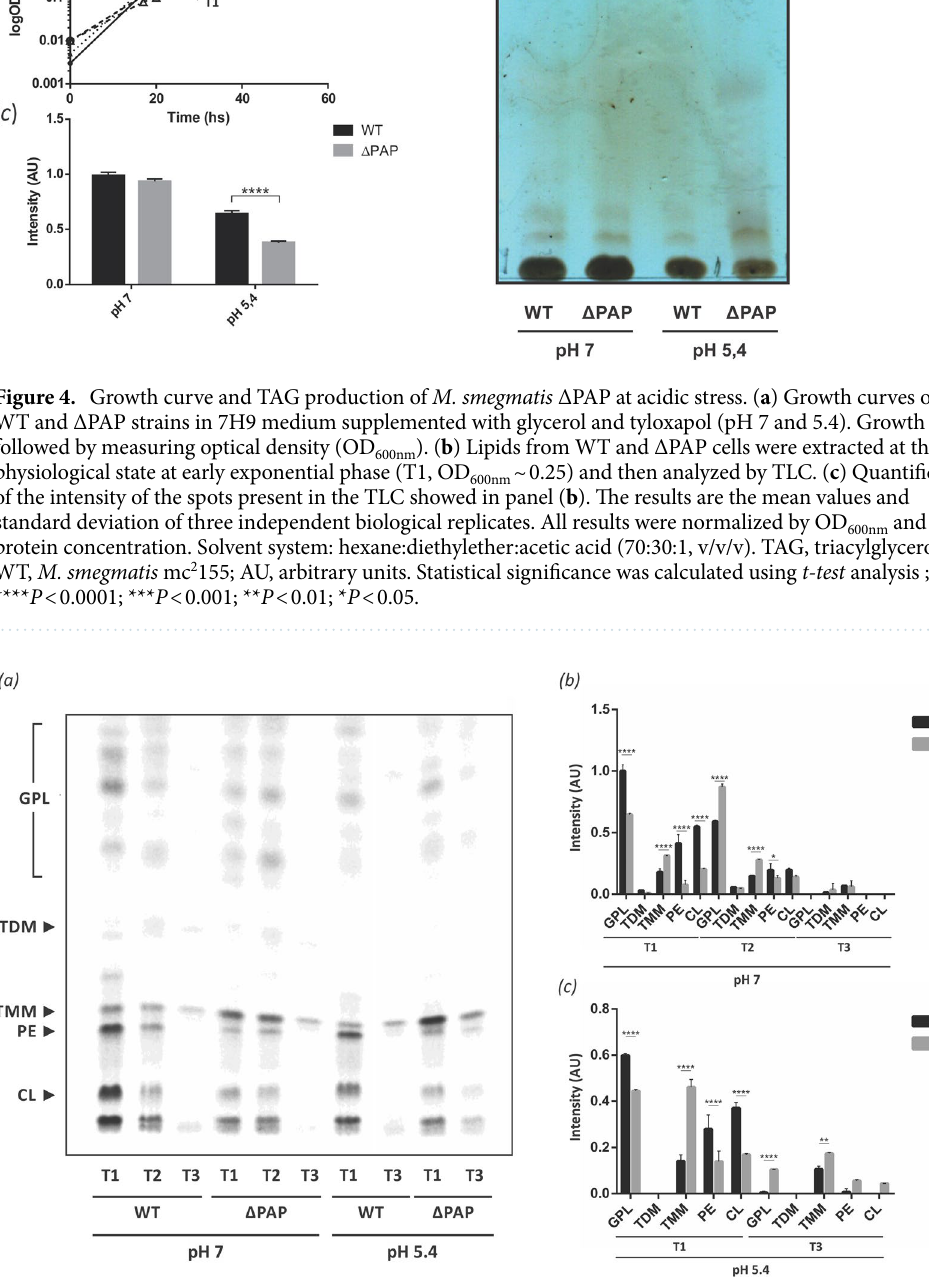
Figure 5. Lipid analysis of the envelope of M. smegmatis ΔPAP strain. ( a ) Cells from WT and ∆PAP cultures grown in 7H9 medium (pH 7 and 5.4) were labelled with [ 14 C]-acetate at the same physiological state at early (T1, OD 600nm ~ 0.25), mid-exponential (T2, OD 600nm ~ 0.5) and stationary (T3, OD 600nm ~ 1.5) phase for 1 h at 37 °C. Cultures were normalized by OD and after organic extraction; 14 C-labelled lipids were separated by TLC. ( b ) and ( c ) Quantification of the intensity of the spots of the TLC showed in panel ( a ). The results are the mean values and standard deviation of three independent biological replicates. Solvent system: chloroform:methanol:water (20:4:0,5, v/v/v). GPL, glycopeptidolipids; TDM, trehalose dimycolate; TMM, trehalose monomycolate; PE, phosphatylethanol-amine; CL, cardiolipin; WT, M. smegmatis mc 2 155; AU, arbitrary units. Statistical significance was calculated using two-way ANOVA test followed by Bonferroni correction; **** P < 0.0001; *** P < 0.001; ** P < 0.01; * P <